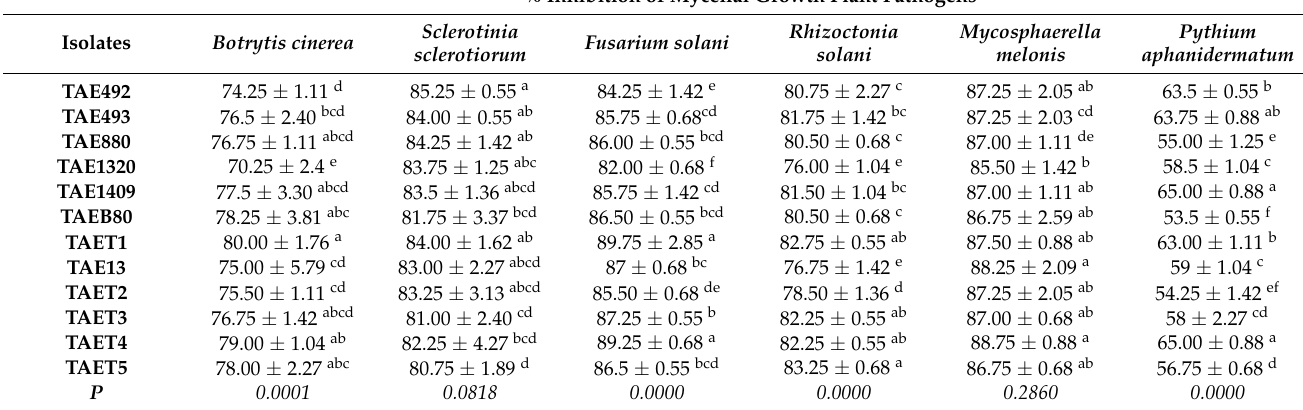
Table 2. Antagonistic potential of T. aggressivum f. europaeum isolates against six phytopathogens in dual culture on PDA radial mycelia growth of the pathogen, R1: radial growth of pathogen in control plates, R2: radial growth of pathogen in dual culture plates. Means with the same letter are not significantly different (LSD) according to ANOVA test ( p < 0.05).